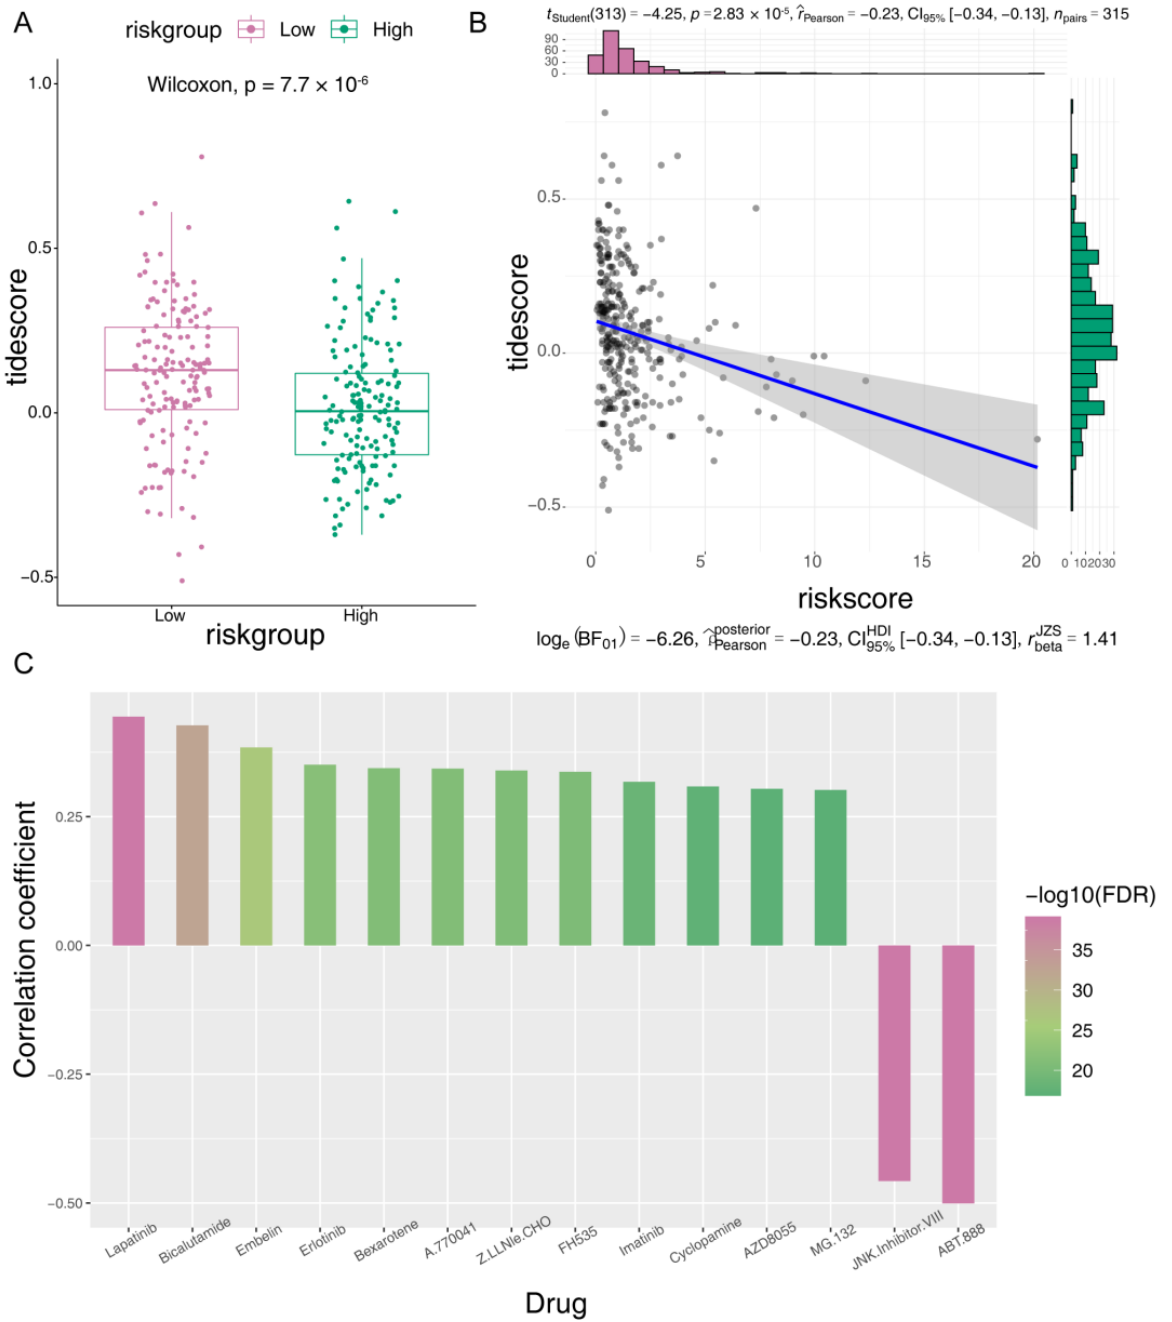
Figure 5. Prediction for immune and chemotherapeutic drugs susceptibility. ( A ) Differences in the TIDE score between the high- and low-risk groups. ( B ) Correlation scatter plots of TIDE score and risk score. ( C ) Correlation analysis of the IC50 of 14 drugs and risk score.